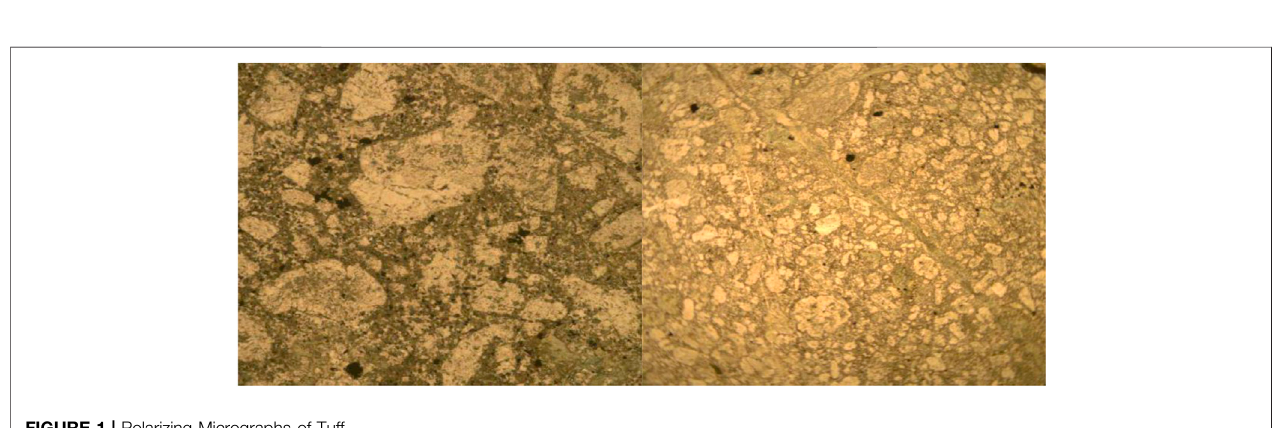
FIGURE 1 | Polarizing Micrographs of Tuff.